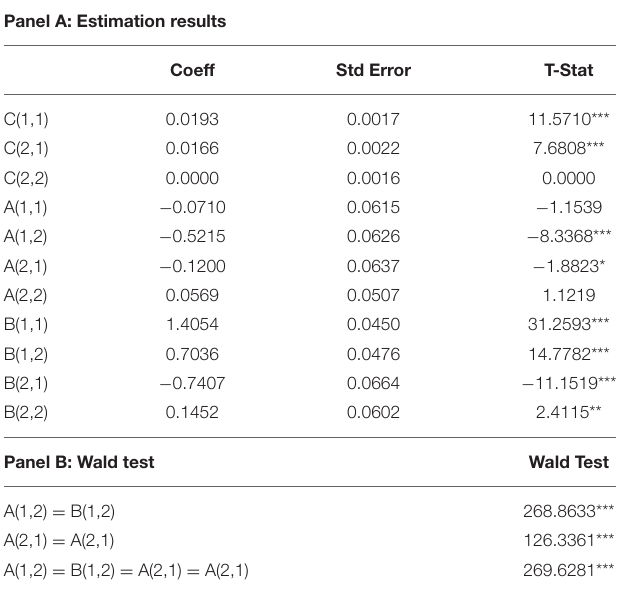
TABLE 4 | Estimation of VAR-BEKK-GARCH (3,1,1) for volatility spillover. Panel A: Estimation